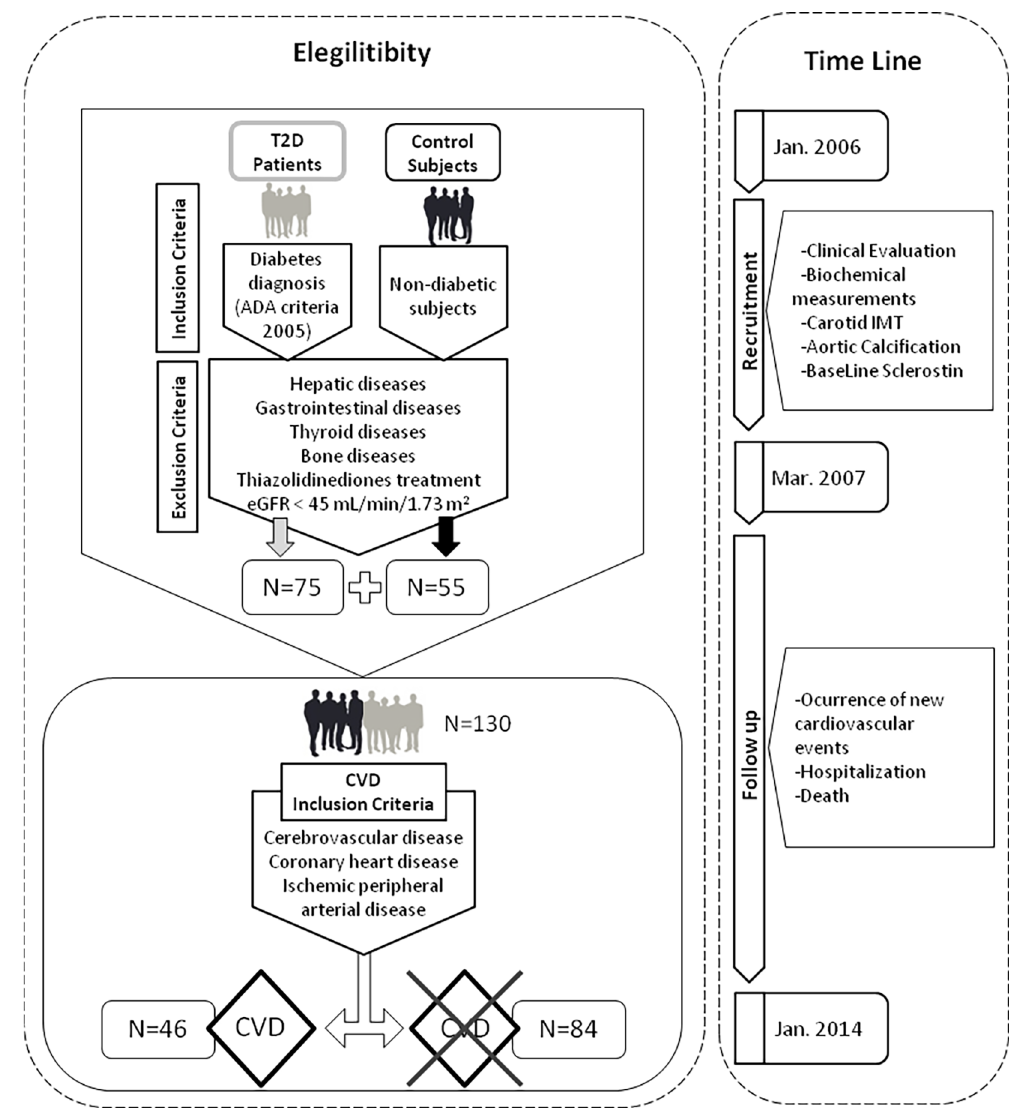
Fig 1. Flowchart indicating the study design, and the inclusion and exclusion criteria for